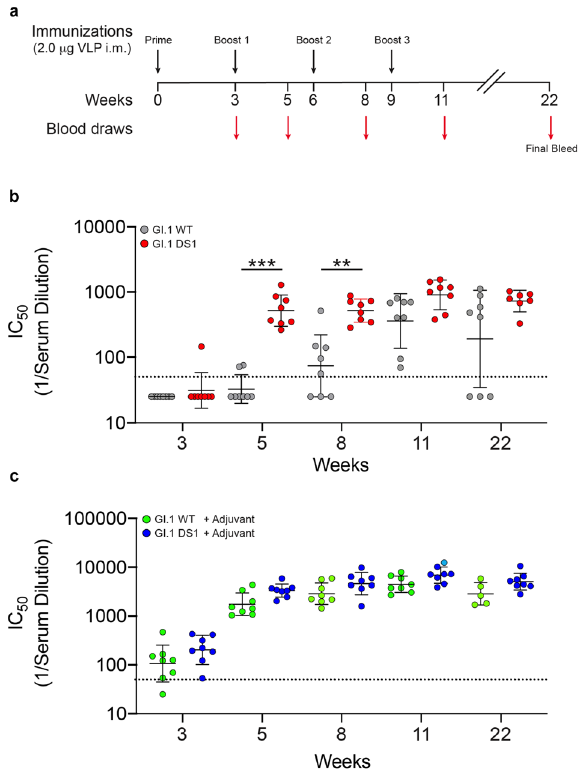
Fig. 5 Mice immunizations with stabilized GI.1 VLPs produces high titers of blockade antibody responses after two injections without alum. a Balb/c mice were immunized with two micrograms of either GI.1 WT or GI.1 DS1 VLPs intramuscularly at weeks 0, 3, 6, and 9. Blood draws were performed at weeks 3, 5, 8, and 11. To test durability of immune response, fi nal bleed was performed 13 weeks after the last immunization. For each blood draw, HBGA blockade titers were assessed. b Comparison of blockade antibody titers between GI.1 WT (gray circles) and GI.1 DS1 (red circles) in the absence of adjuvant. Disul fi de stabilization of norovirus VLPs leads to fast development of blockade titers compared to wild-type VLPs (compare blockade titers after second immunization). c Comparison of blockade titers between GI.1 WT (green circles) and GI.1 DS1 (blue circles) in the presence of adjuvant (alum). No signi fi cant differences at any time point are observed, indicative of potentially stabilizing effect of GI.1 WT VLPs by alum. Limit of detection (titer = 80) is indicated with a horizontal dotted line. Geometric mean titers ± geometric SD are shown in scatter dot plot. P values were determined by two-tailed Mann – Whitney tests. * P ≤ 0.05, ** P ≤ 0.01, *** P ≤ 0.001. There were eight mice per group for VLP immunizations and six mice per group for controls (PBS and PBS +